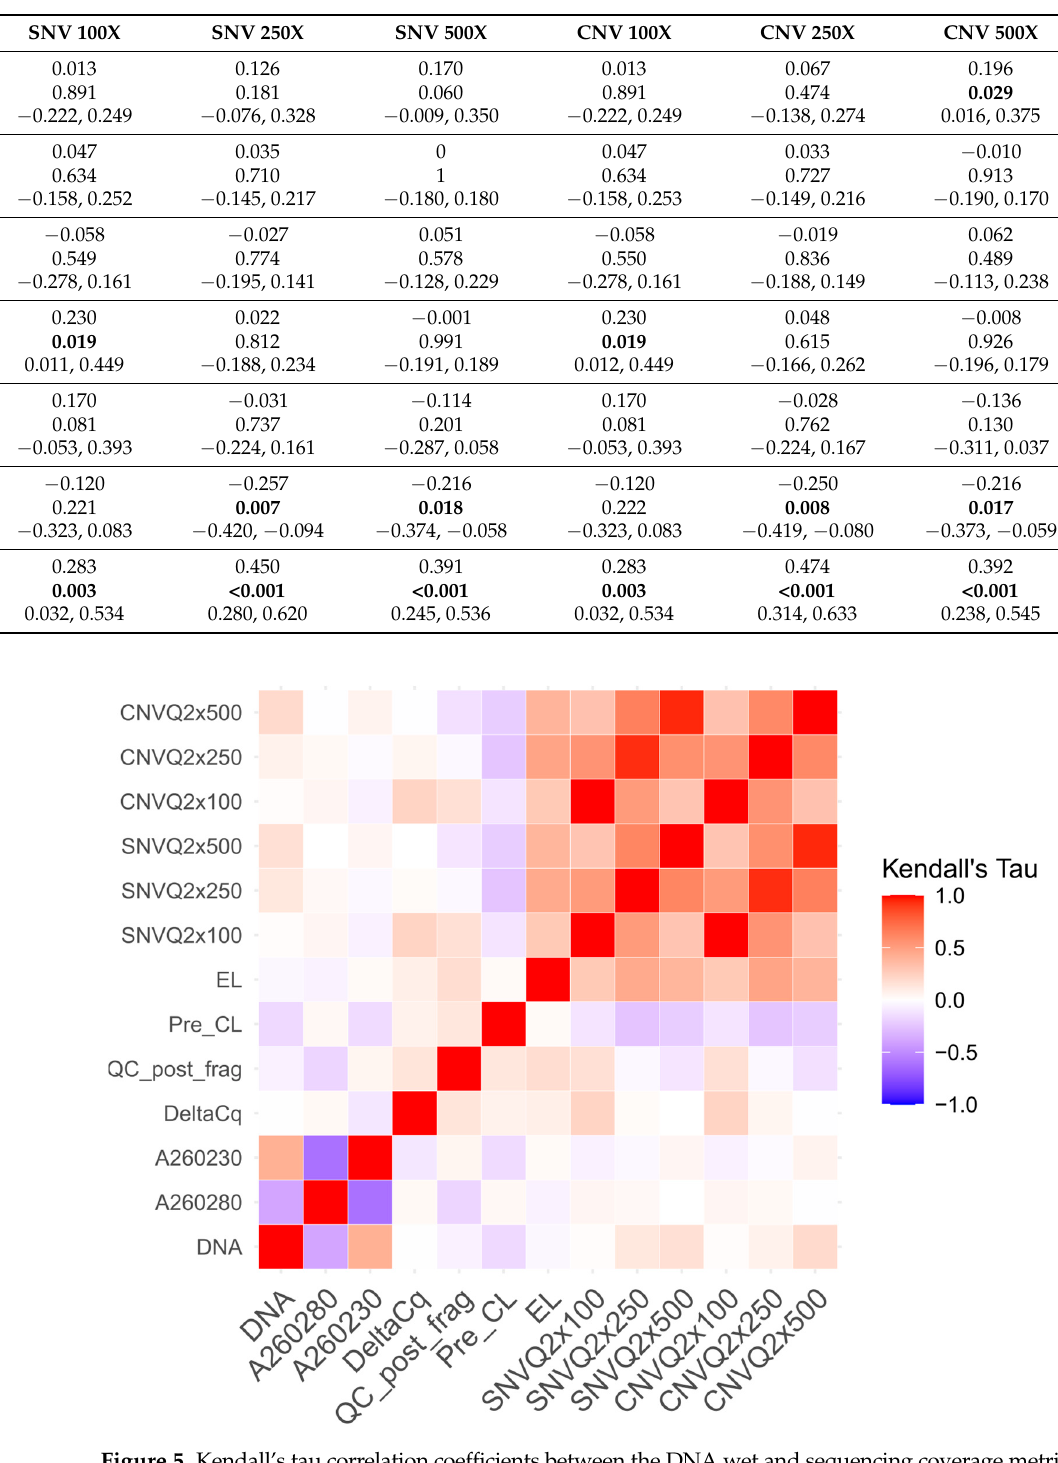
Figure 5. Kendall’s tau correlation coefficients between the DNA wet and sequencing coverage metrics.